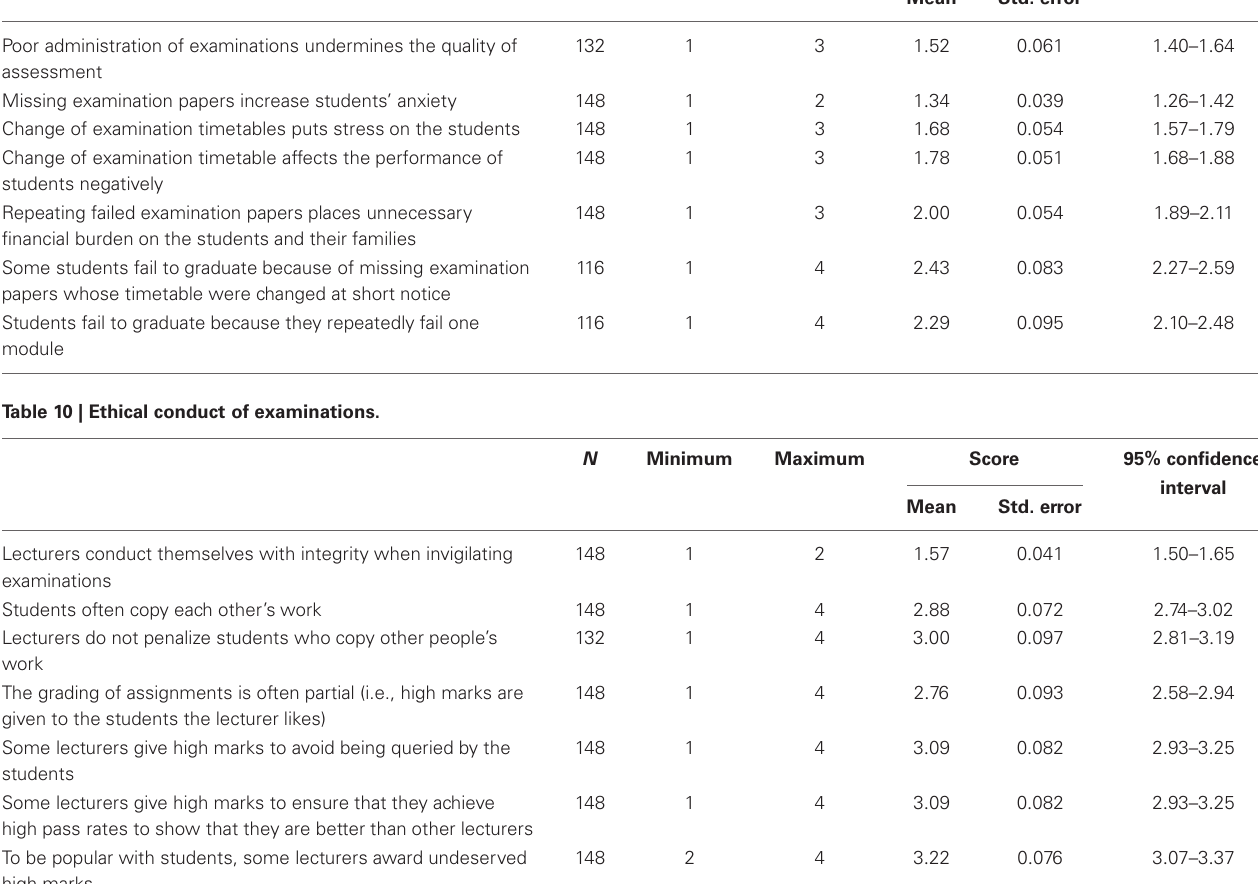
N Minimum Maximum Score 95% confidence interval Mean Std. error